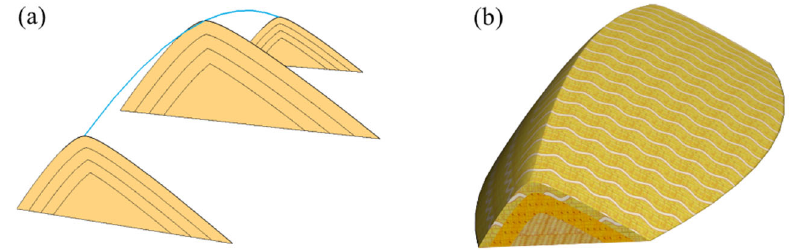
Figure 13. 3D symbol modeling process of Dayue Mountain: ( a ) sections and hinge line of Dayue Mountain and ( b ) 3D symbol model of Dayue Mountain upright anticline.